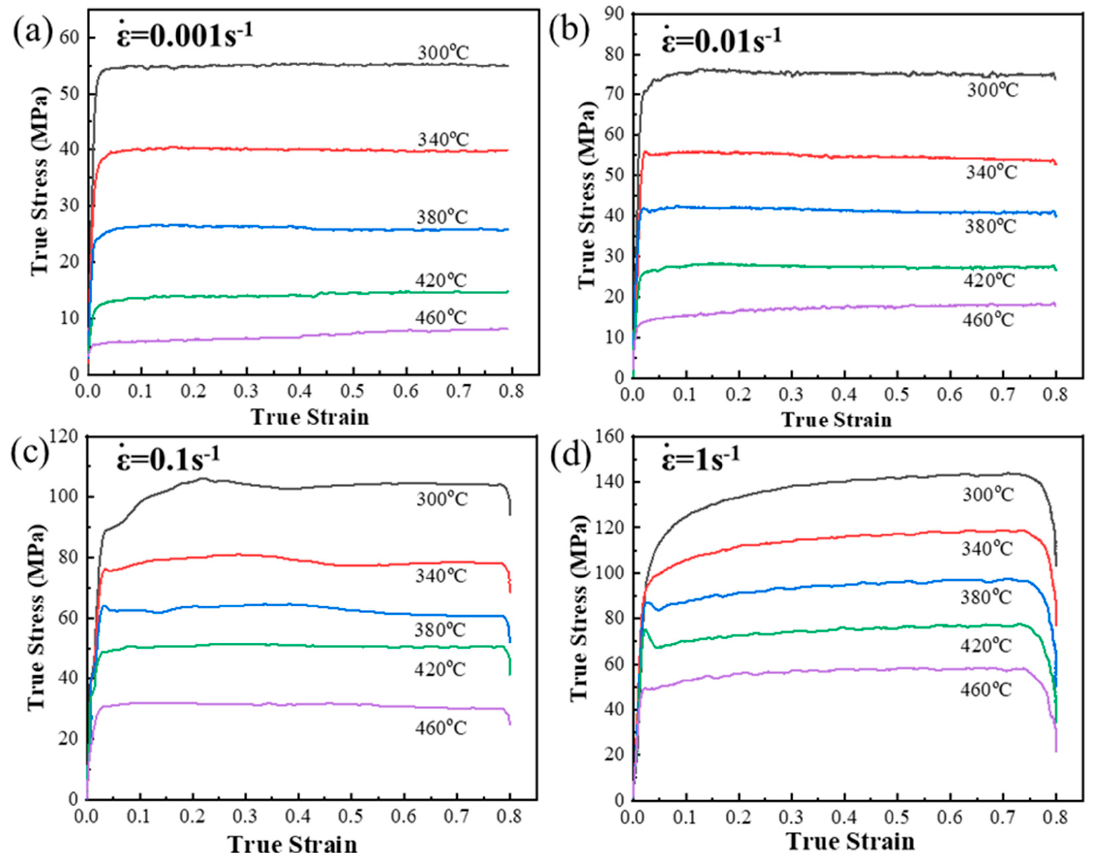
Figure 2. The true stress-strain curves of PM composites with different strain rates: ( a ) 0.001 s − 1 , ( b ) 0.01 s − 1 , ( c ) 0.1 s − 1 , ( d ) 1 s − 1 .